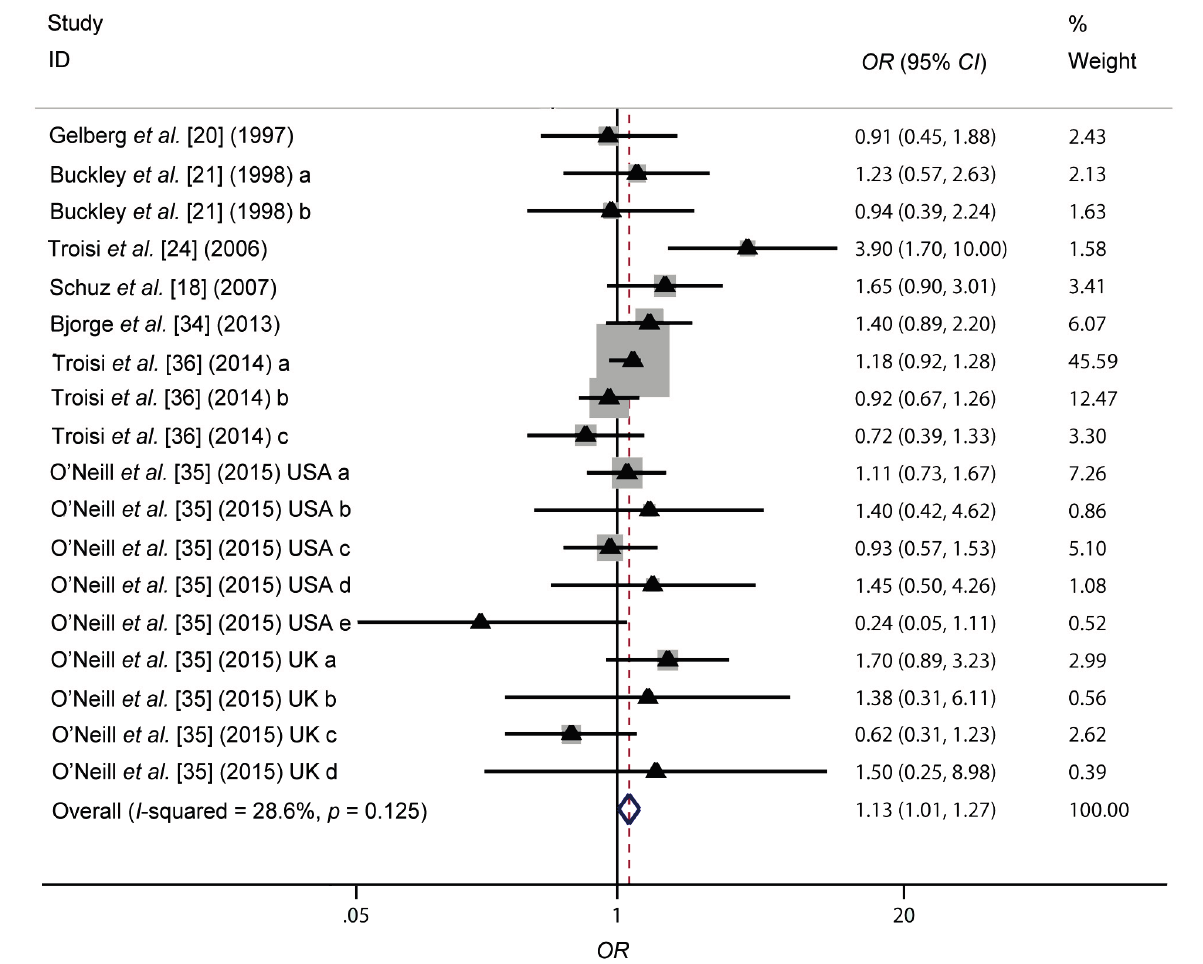
Figure 2. Forest plots of the fixed-effect model for the association of high birth weight and bone tumor risk. The horizontal lines and triangles denote the corresponding ORs and 95% CIs , while the vertical dotted line suggests the corresponding pooled ORs . The gray boxes point to the weight for each study. The open diamond corresponds to the overall OR and 95% CI